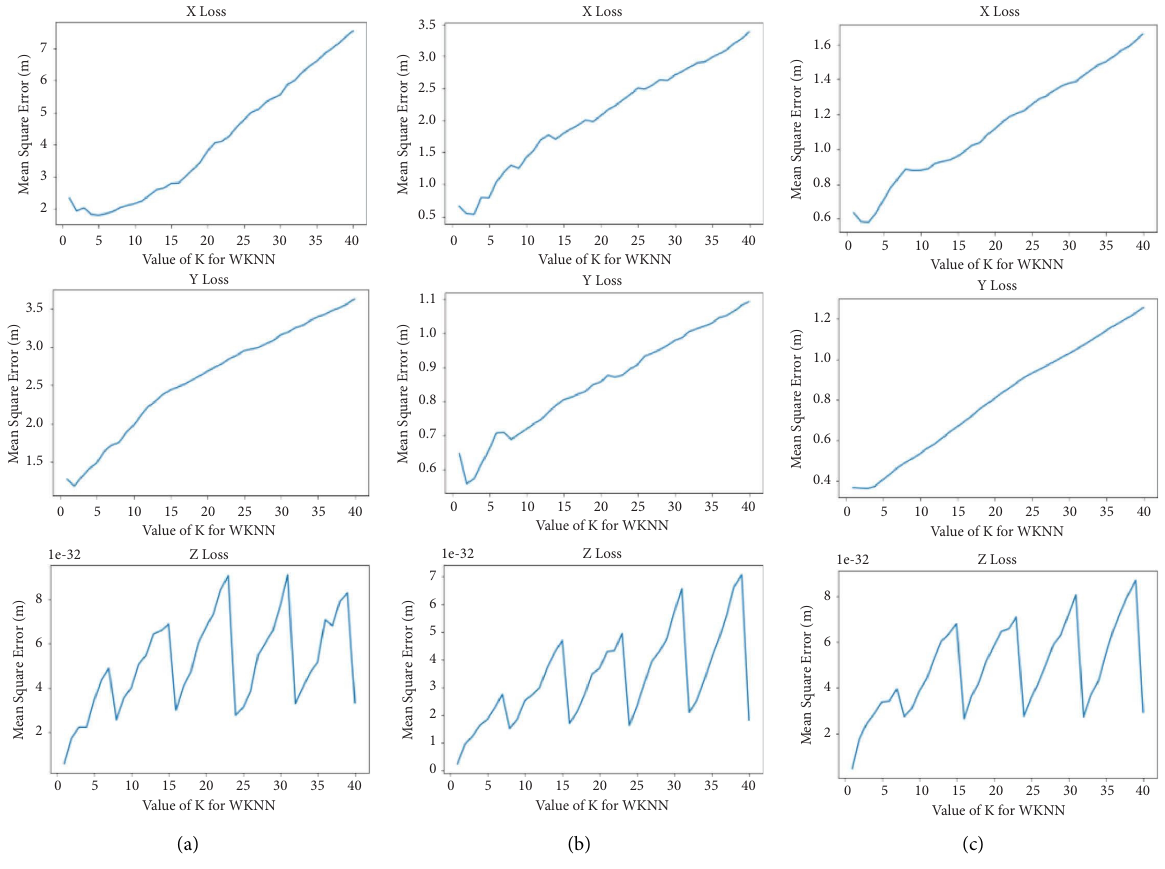
Figure 5: WKNN loss (a) 1 AP pair, (b) 2–10 AP pairs, and (c) 1–10 AP